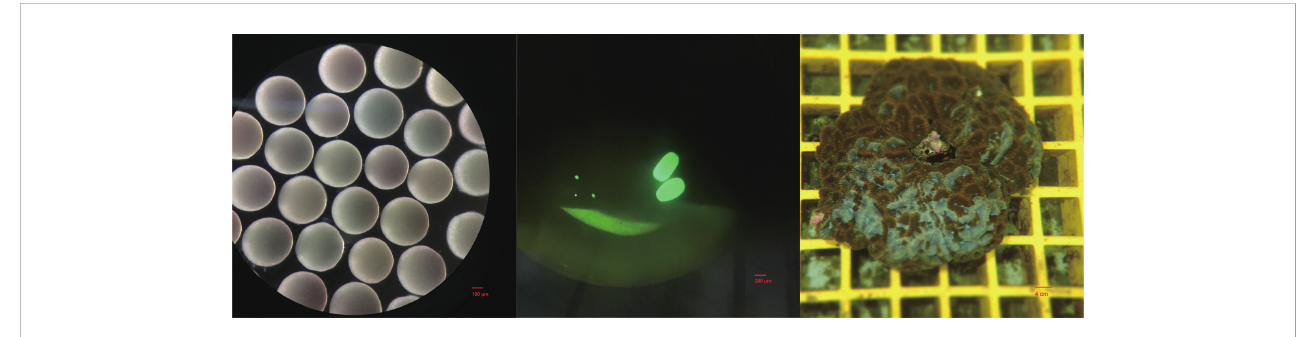
FIGURE 1 The eggs (left), larvae (middle), and adult (right) of D. favus